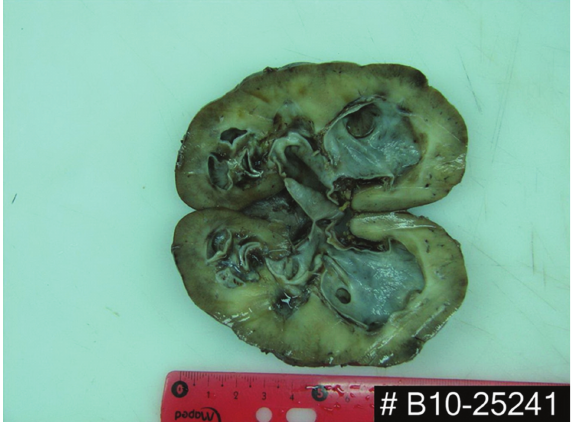
Figure 1: Macroscopic view of the kidney.